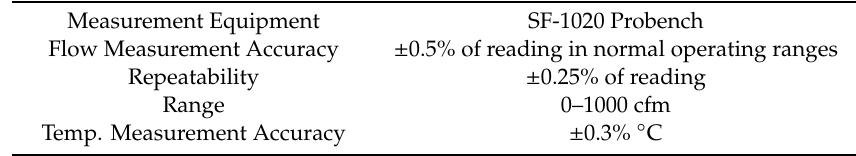
Table 1. Measurement conditions of the pressure drop on the gasoline particulate filter